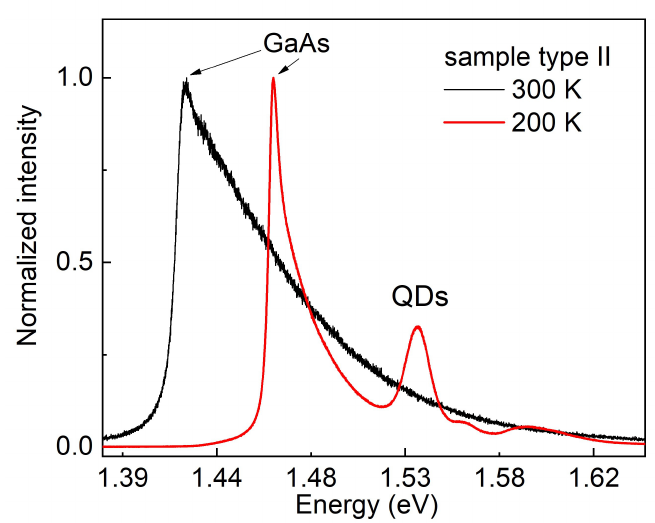
Figure 4. PL data from a type II sample taken with a green laser (532 nm) at T R (black) and 200K (red) with 0.06mW excitation power. The ground state emission E 0 = 1.534eV from QD ensemble is visible at 200K.